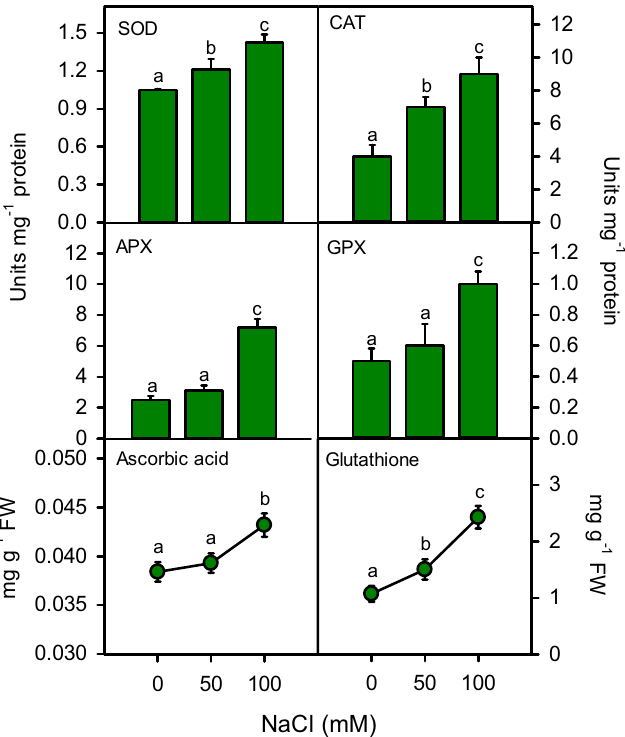
Figure 9. Activities of antioxidant enzyme including SOD, CAT, APX and GPX and contents of ascorbic acid and glutathione in Moringa oleifera under different salinity treatments. Different letters indicating significant differences at P <